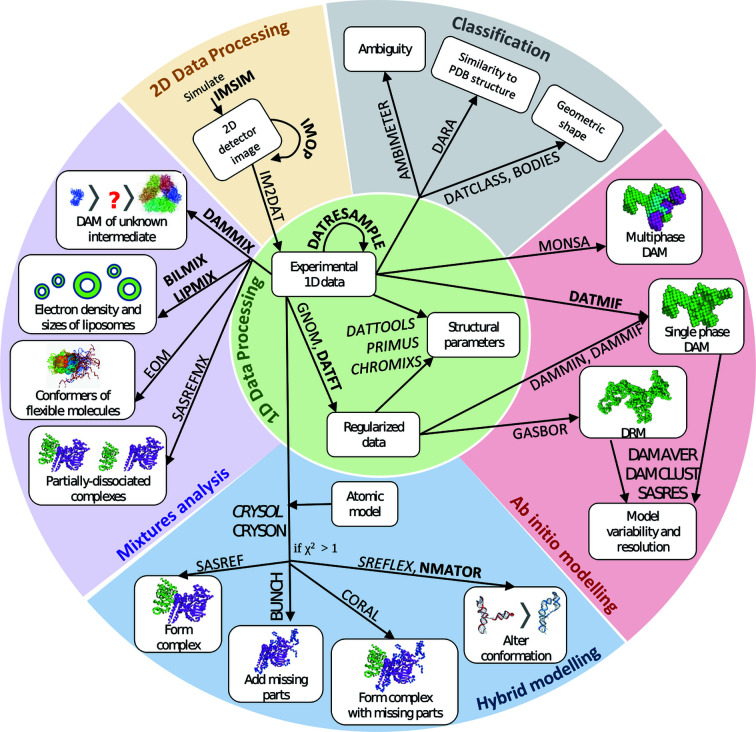
General scope of the ATSAS suite, including specific software for different use cases. Names in boldface indicate software newly added to ATSAS 3.0, while names in italics indicate updated programs (DAM: dummy-atom model; DRM: dummy-residue model).